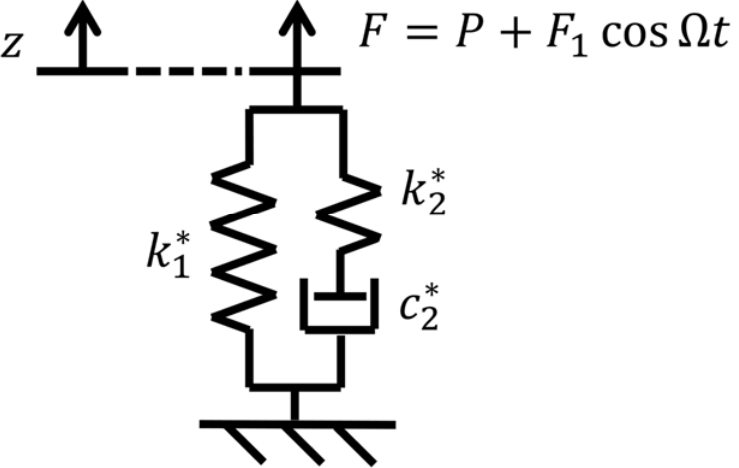
Figure 4. Non-linear macro-mechanical model of unit length of elastomeric material with preload- dependent parameters.